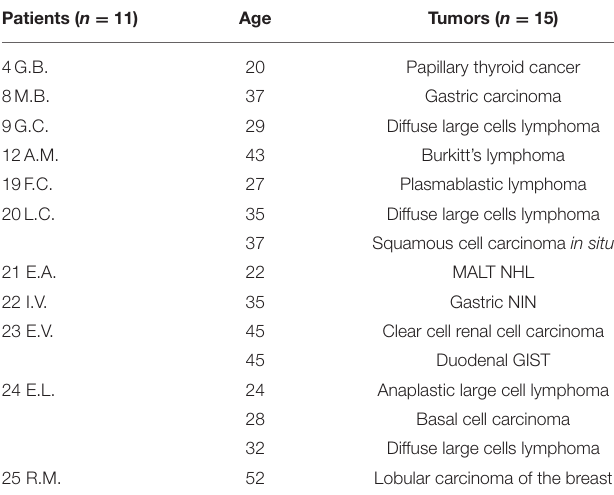
TABLE 2 | Tumors in adult age ( > 18